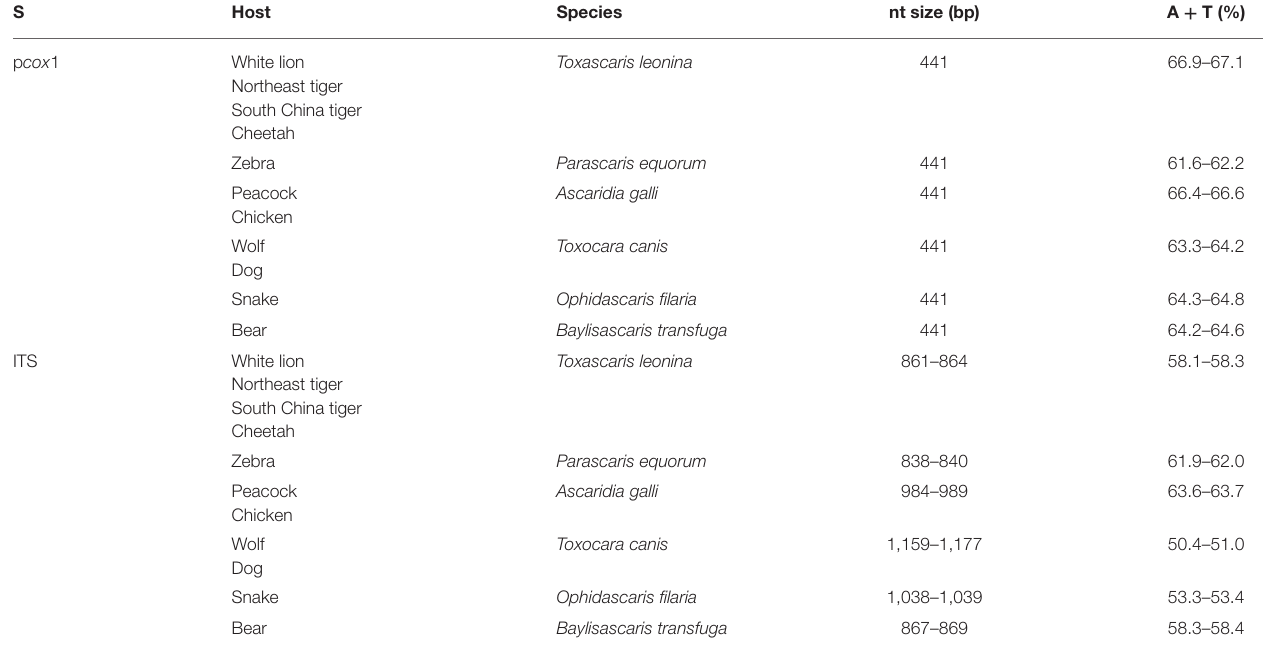
TABLE 1 | The amplification length results of p cox 1 and ITS